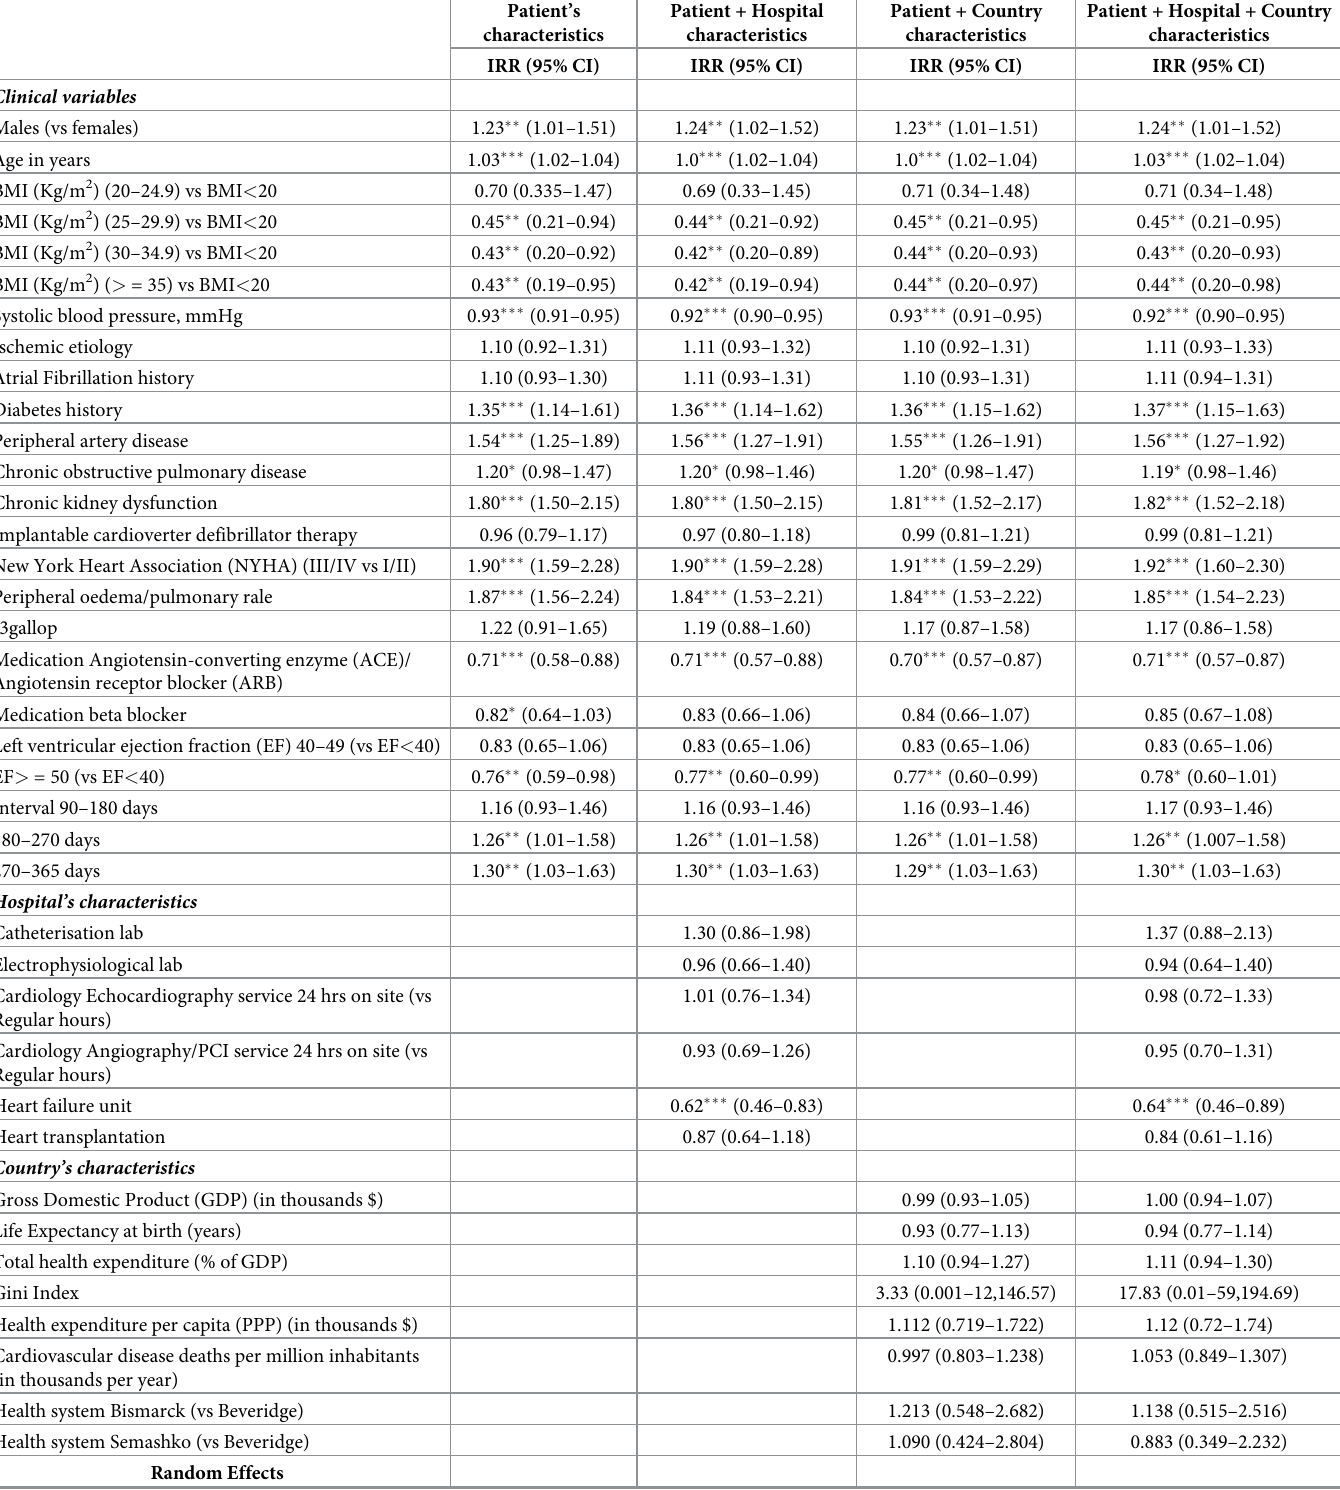
Table 3. Factor associated with 1-year all-cause mortality for patients with chronic HF, PWE survival model, incidence rate ratios and 95%